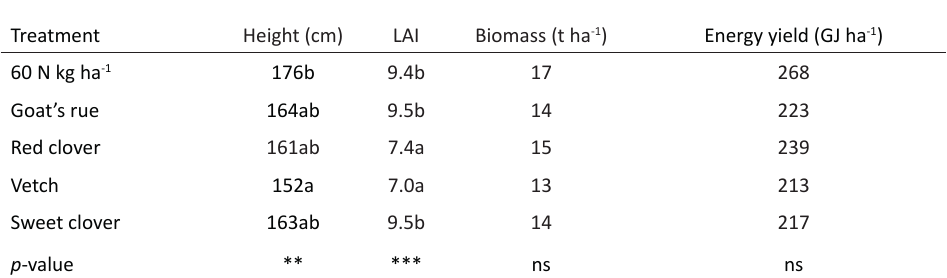
Table 2. Leaf area index (LAI), height, aboveground biomass and energy yield of Jerusalem artichoke treated with N fertilizer or intercropped with legumes during two growing seasons (2009 and 2010) in Helsinki, Finland.